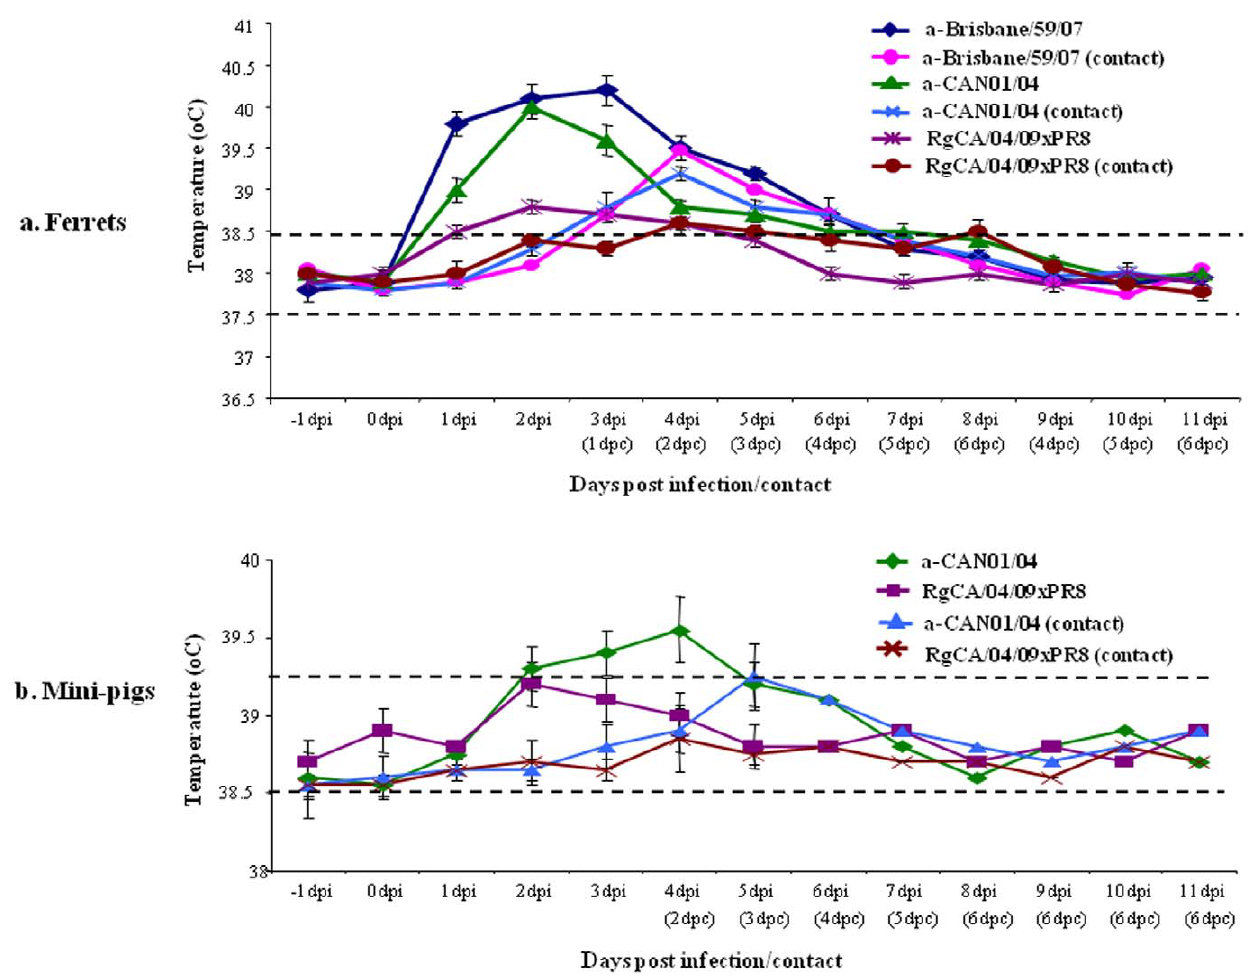
Figure 3. Monitoring of body temperature in ferrets and mini-pigs. Mean b ody temperatures of ferrets (a) and mini-pigs (b) infected with the pandemic (H1N1) 2009 virus (CA/04/09) or the recent Korean swine H1N1 (CAN01/04) isolate, including naı¨ve contact animals, were monitored daily for 11 days post infection. The range of normal body temperatures are indicated as broken lines. Standard error bars are shown.